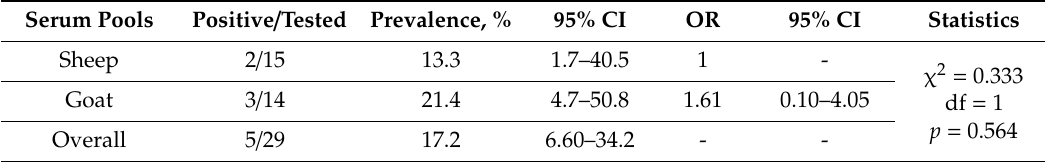
Table 3. Detection of Coxiella burnetii DNA in 29 pooled serum samples.